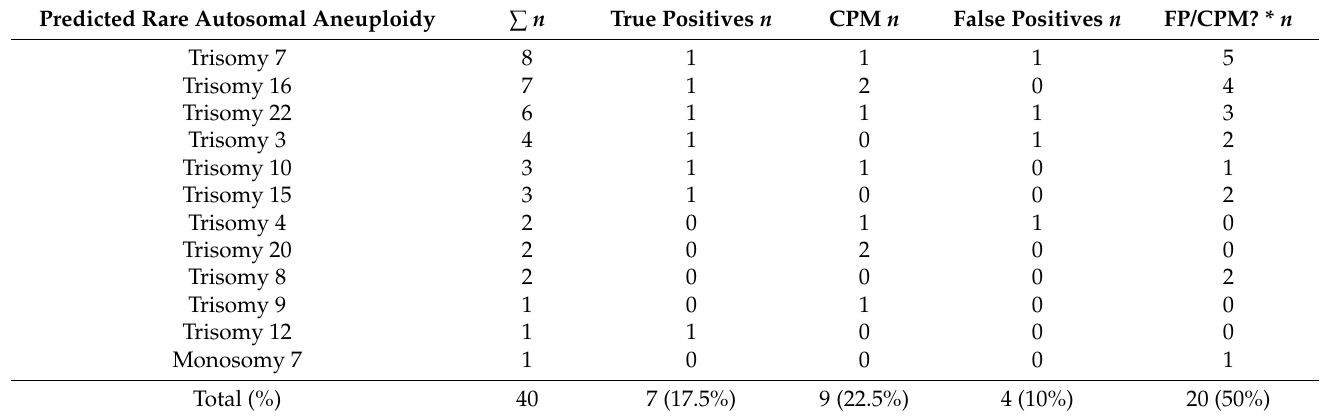
Table 1. The outcomes of the cases with a positive cfDNA test result for rare autosomal trisomies. Predicted Rare Autosomal Aneuploidy ∑ n True Positives n CPM n False Positives n FP/CPM? *